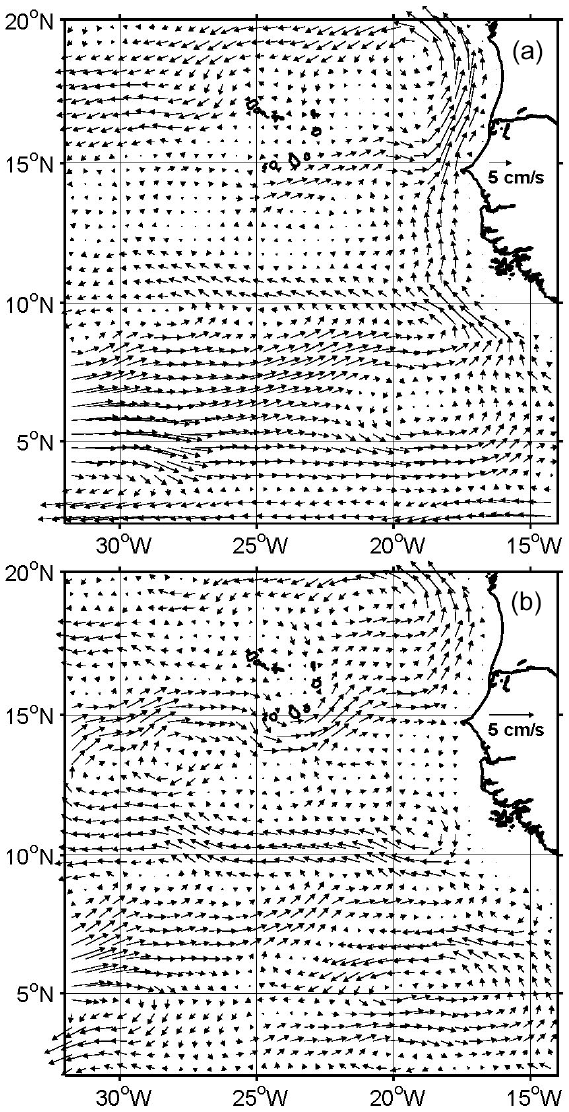
Figure 2. SODA model mean circulation for the period 2001 to 2010 for the layers 50 to 200m (a) and 200 to 400m (b) .